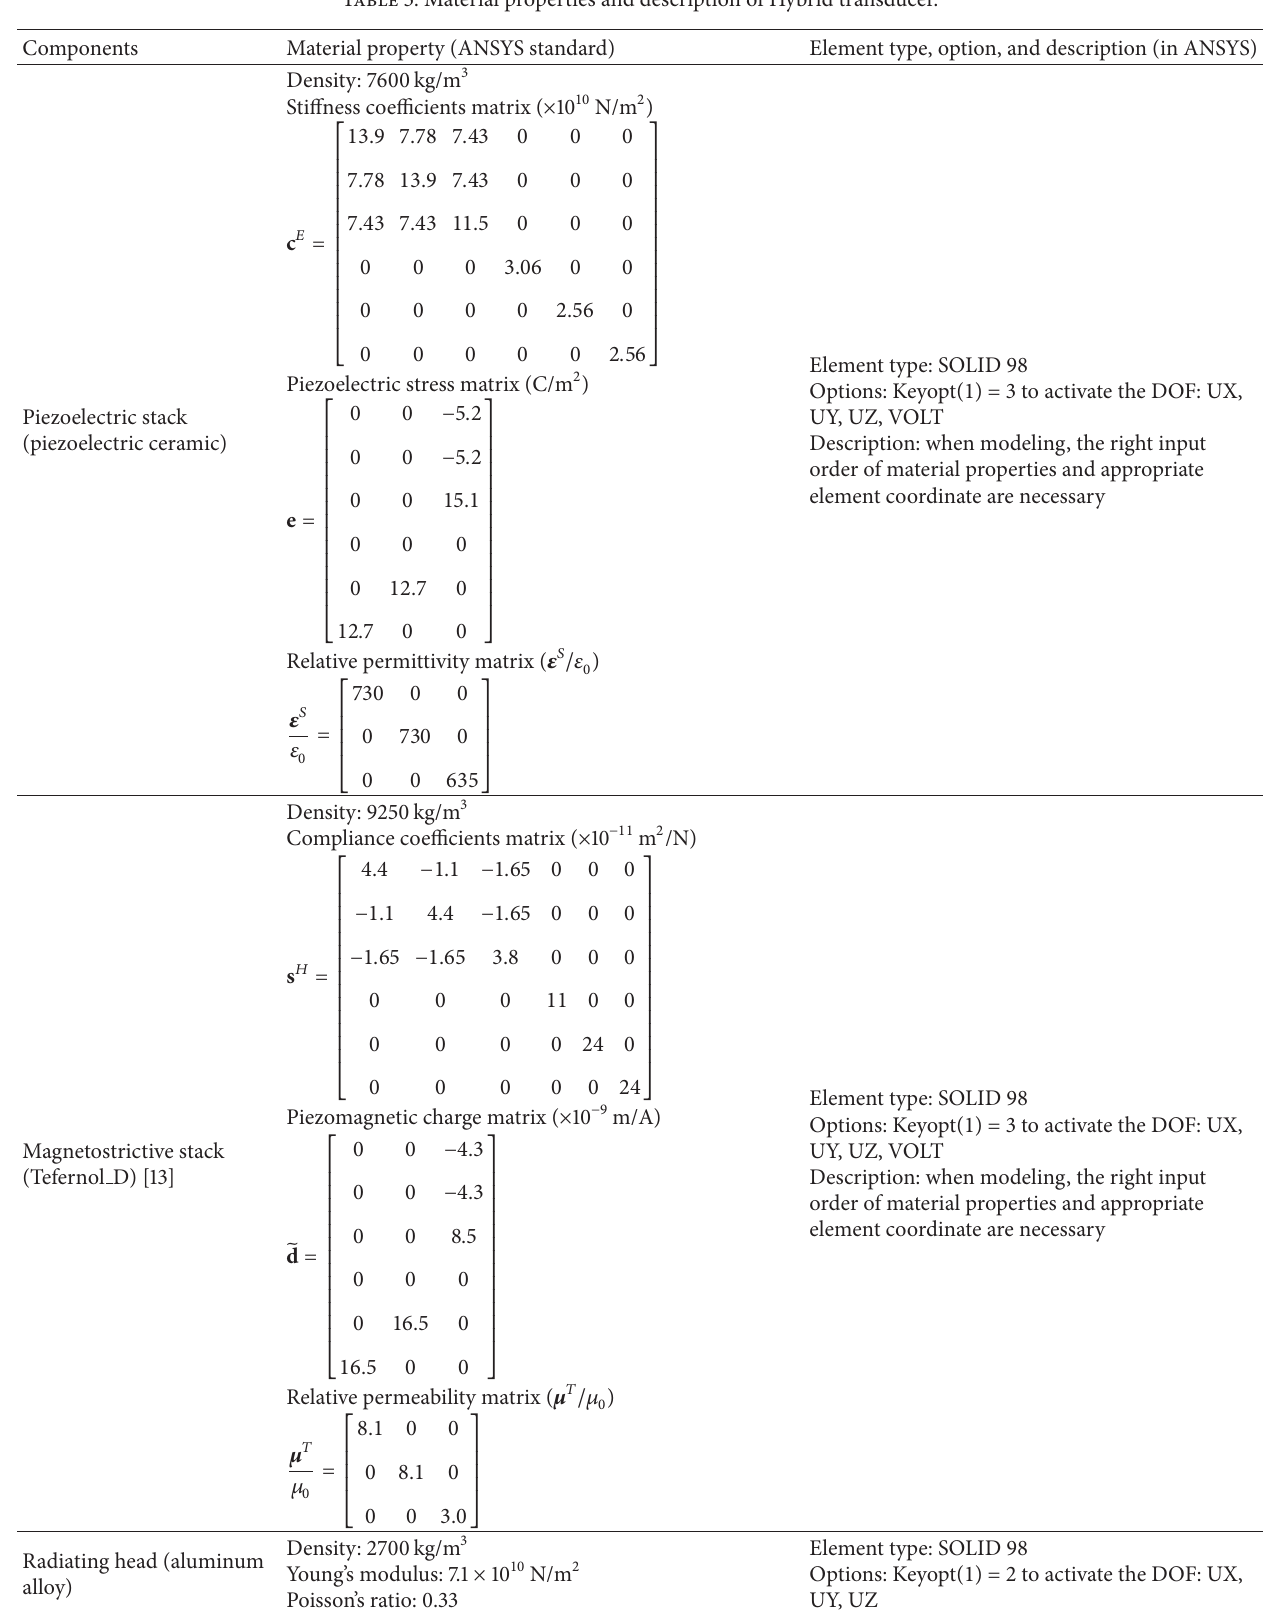
Table 3: Material properties and description of Hybrid